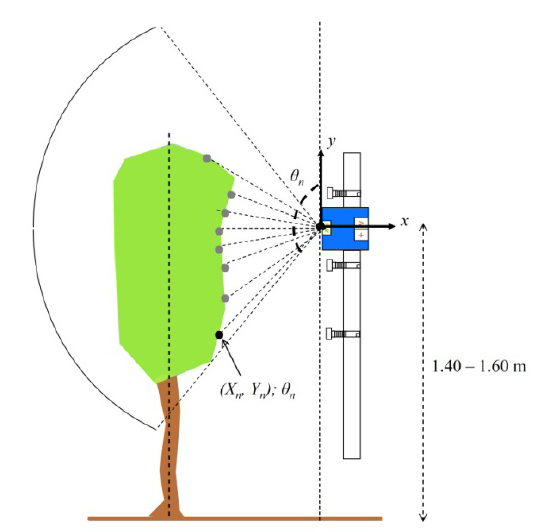
Figure 4. Functioning principle of the LIDAR sensor. The laser beams obtain for each crop slice a variable number of identified points according the distance to the sensor and angle from the horizontal.